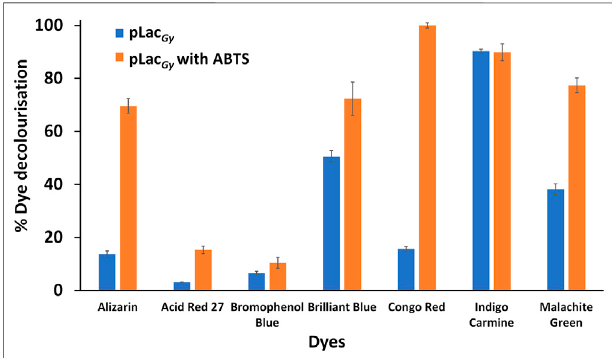
FIGURE 3 | Decolourisation of organic dyes with pLac Gy with and withoutABTSasredox mediator.Assaymixtureincluded 1 µM pLac Gy ,1 mM ABTS, 50 µM CuCl 2 , 0.05 mg/ml organic dye in 0.04 M Britton-Robinson buffer (pH5.0). The mixture was incubated for 18 h at 60 ° C with shaking at 500 rpm. All experiments were conducted in triplicates and error bars represent standard